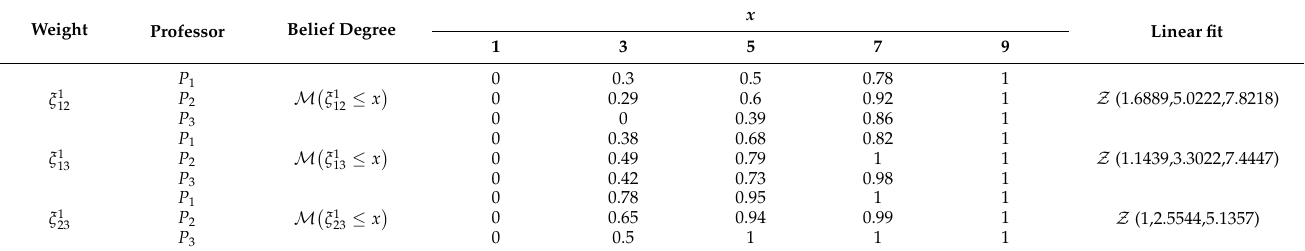
Table 5. The collated data for criteria C 11 , C 12, and C 13 .